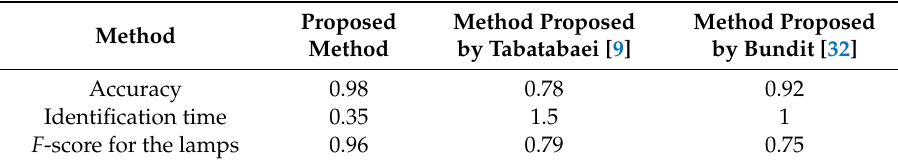
Table 3. The comparison of data processing